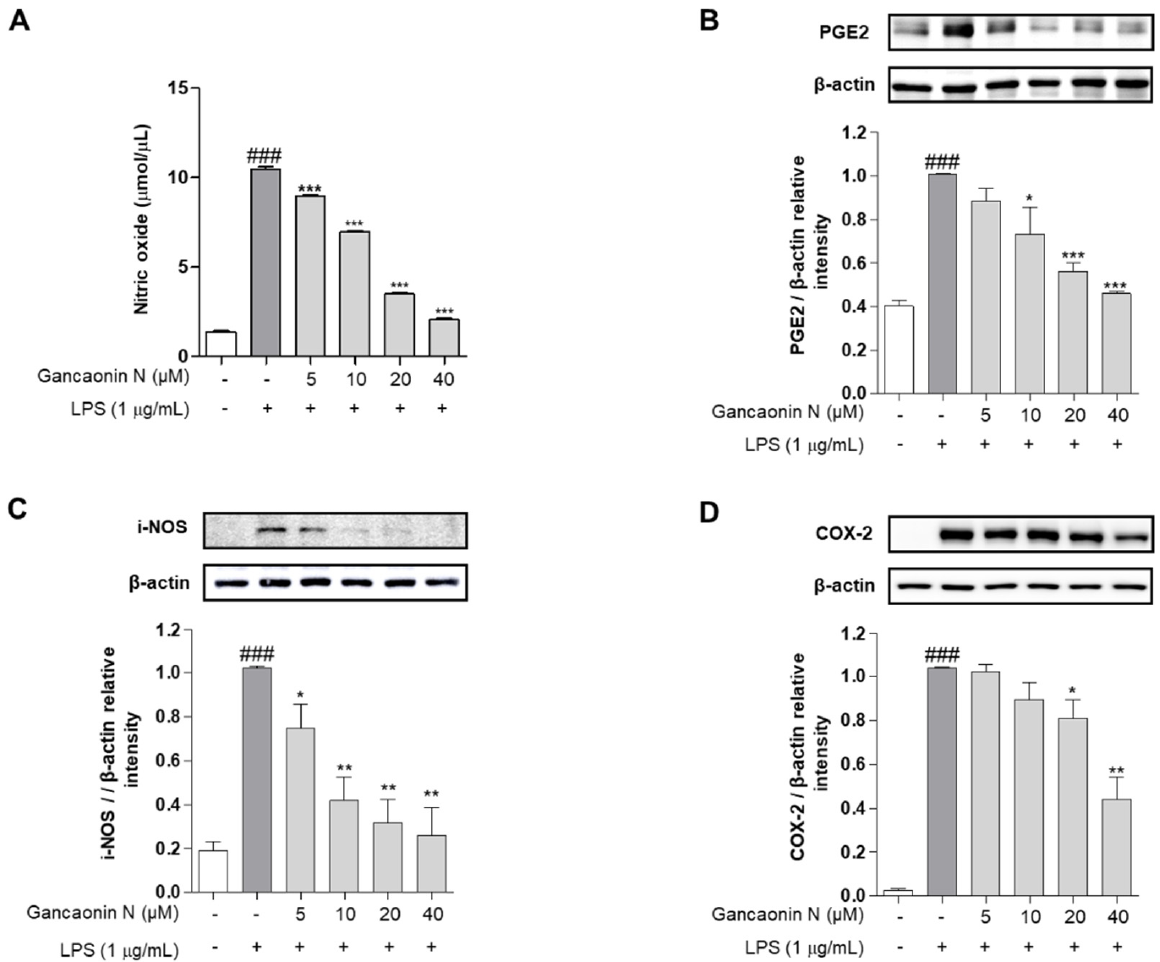
Figure 2. Effects of Gancaonin N on nitric oxide production ( A ) and protein levels of PGE2 ( B ), iNOS ( C ) and COX-2 ( D ) in LPS-induced RAW264.7 cells. Gancaonin N (5–40 µ M) was pretreated 2 h prior to LPS-induced inflammation in RAW264.7 cells, incubated for 24 h with LPS (1 µ g/mL). The protein levels of PGE2, iNOS and COX-2 were investigated by immunoblotting assay. Ratio of each protein was determined by ImageJ. Values are represented as means ± SEM. ### p < 0.001 is significantly different from non-treated group; * p < 0.05, ** p < 0.01, *** p < 0.001 are significantly different from only LPS-treated group.